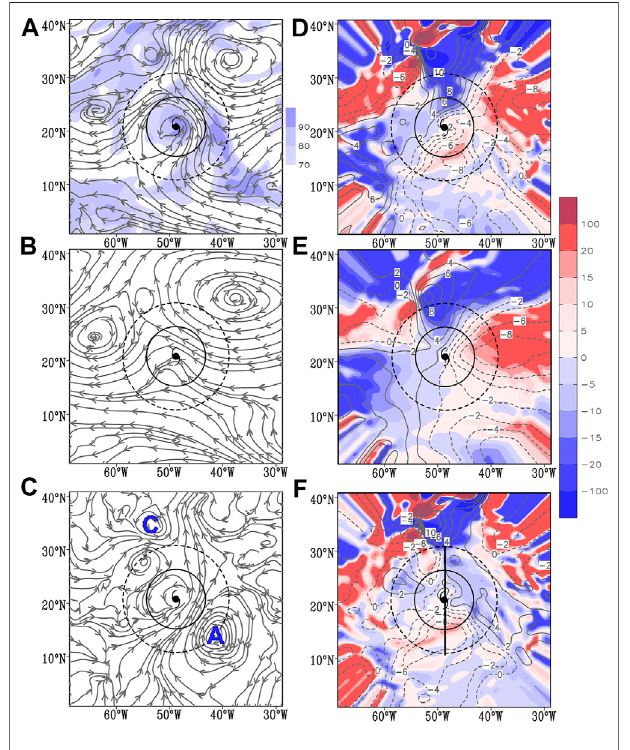
FIGURE 7 | (A, B, C) Streamlines with the shading in (A) indicating the relative humidity averaged from 850 hPa to 700 hPa and (D, E, F) the divergence of the environmental AAM fl ux (AAMFD, shaded, 10 6 m 3 s − 2 ) superimposed with the radial fl ow [contours, solid (dashed) lines indicating the out fl ow (in fl ow) at 2 m s − 1 intervals] (A, D) for the total fi eld after removing the TC vortex (B, E) for low-frequency, and (C, F) for the synoptic- scale fi eld at 900 hPa at 1800 UTC Sep 17, 2006. “ A ” and “ C ” in blue color in (C) indicate the synoptic-scale anticyclonic circulation and Hurricane Gordon. The black line in (F) denotes the location for the vertical cross-section in Figure 9 . The black solid and dashed circles indicate the radius of the outer closed isobar (ROCI, with a radius of 555 km) and R (cid:2) 1,000 km.